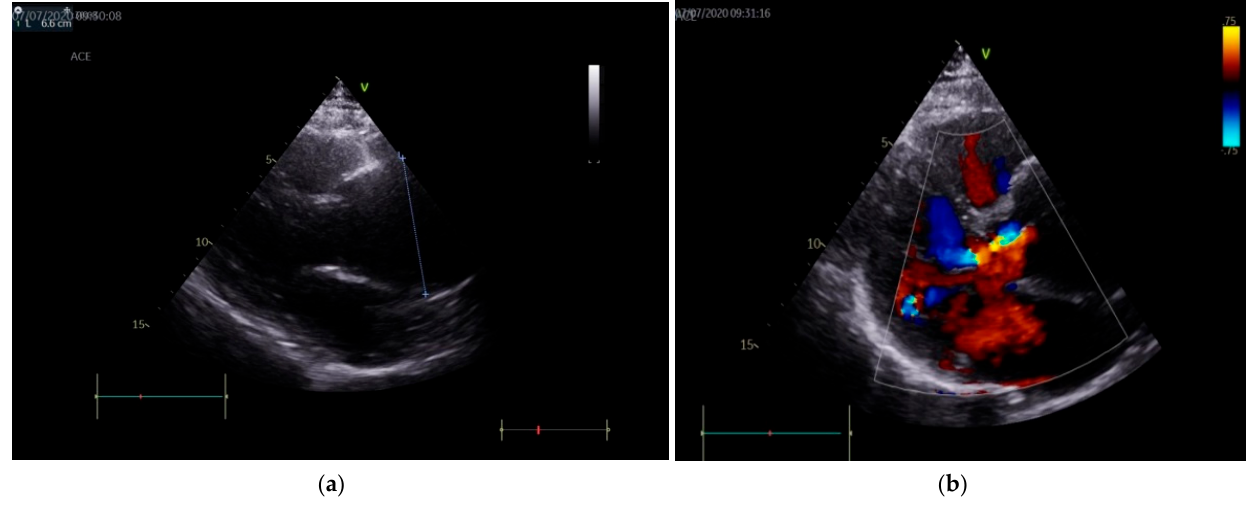
Figure 1. ( a ) Echocardiography (parasternal long axis view): aortic aneurism with diameter of 6 cm, indicated by the oblique line. ( b ) Color Doppler echocardiography: moderate/severe aortic regurgitation